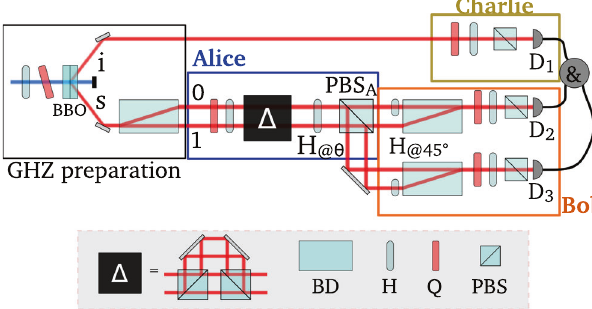
Fig. 4 Experimental setup. Two crossed-axis BBO crystals are pumped by a He-Cd laser centered at 325 nm, producing pairs of photons at 650 nm entangled in the polarization degree of freedom 54 . The signal ( s ) photon is sent through a BD which deviates only the horizontal-polarization component, producing a tripartite GHZ state on two photons using polarization and path degrees of freedom. Idler ( i ) photons are sent directly to Charlie ’ s polarization measurements. Signal photons are fi rst measured in polarization by Alice, then Bob maps his path qubit onto a polarization qubit for his measurements. H stands for half-wave plate, Q for quarter-wave plate, and PBS for polarizing beam